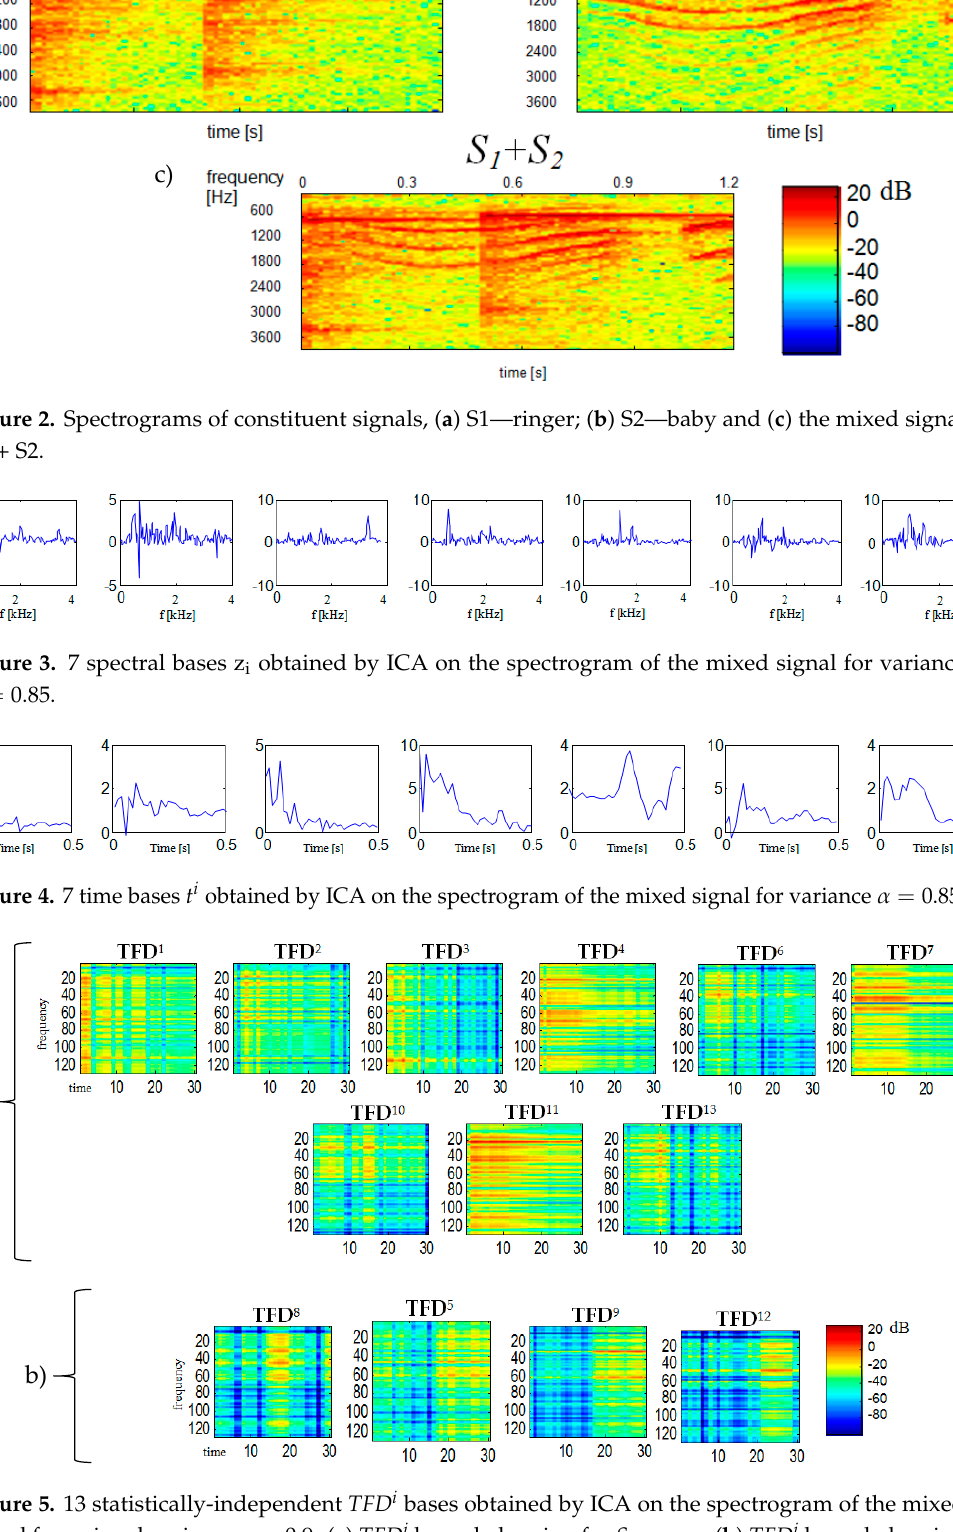
Figure 5. 13 statistically-independent TFD i bases obtained by ICA on the spectrogram of the mixed signal for a signal variance α = 0.9: ( a ) TFD i bases belonging for S 1 source ( b ) TFD i bases belonging for S 2 source.